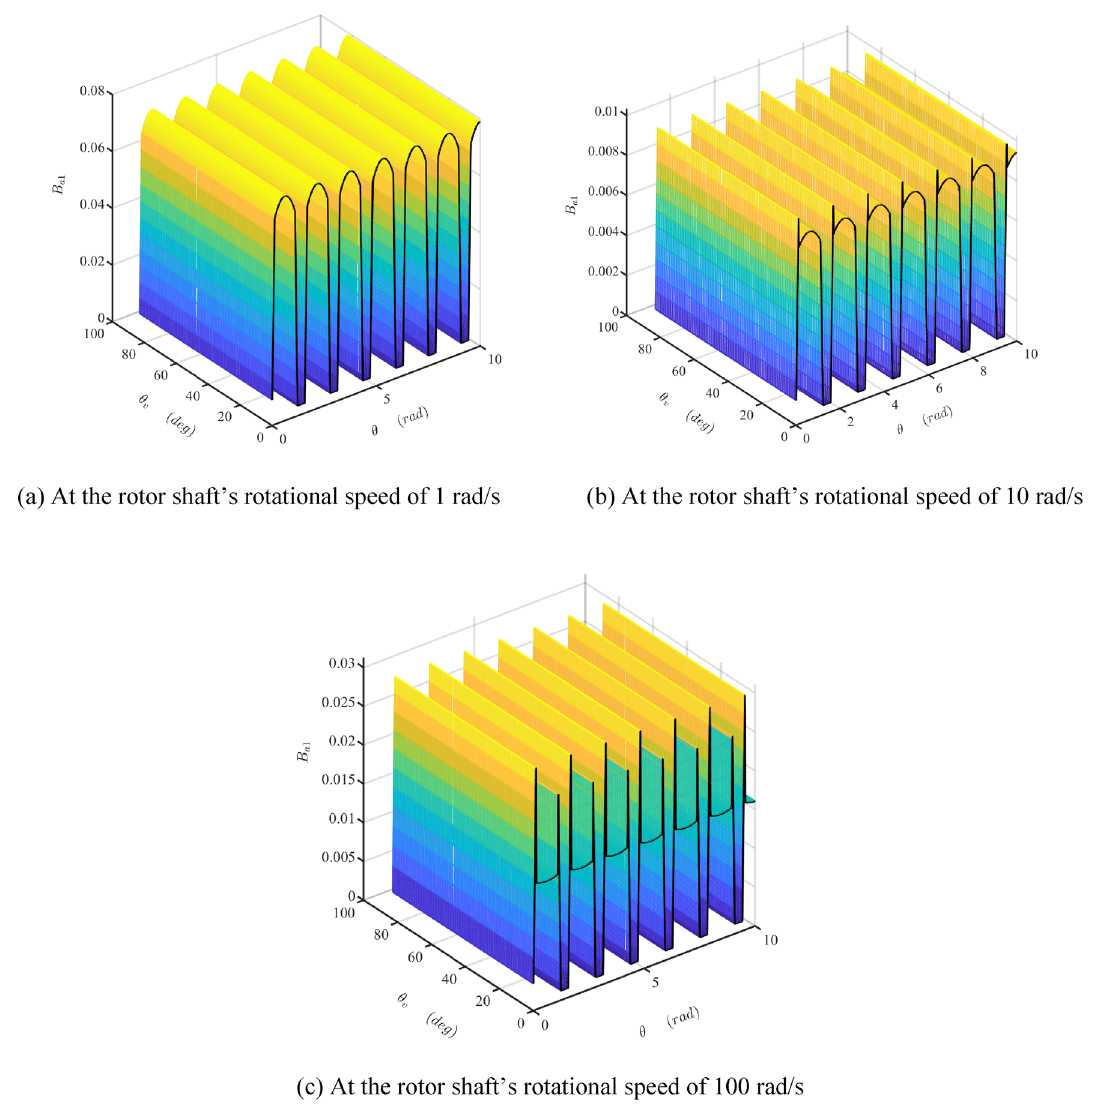
Figure 13. The map of the damper coefficient B a1 at three different the rotor shaft’s rotational speeds. (Matlab2019a. https:// ww2. mathw orks. cn/ produ cts/ get- matlab. html?s_ tid= gn_ Figure 15 indicates the maximum value of the B a2 (denoted as B a2max ) linearly increases in ̇𝜃 -axis and non- linearly increased in 𝜃 v -axis. The relative range of B a2 is about 0.42 in most areas. When both the shaft rotational velocity and the valve angle are small, the friction force acts as a dominant role, and B a2 becomes very high sharply. Figure 16 presents the map of B a3 when the rotor shaft’s rotational speed increases from 1 to 100 rad/s. Similar to the tendency of B a2max , B a3 increases linearly or nonlinearly with the increase of the shaft’s rotational velocity or the valve angle, respectively. But it does not vary with the rotation angle of the shaft. Comparing Figs. 14a, 15a, and 16, it is clear that B a3 is a dominant component in the total damping coefficient when the rotational velocity of the shaft and the angle of the valve are big. Therefore, the maximum value of the damper coefficient, B max , is close to the B a3 , as shown in Fig. 17a. Consequently, the fluctuation of the total damping coefficient is smaller at the bigger value of the high rotational velocity of the shaft and the angle of the valve, as shown in Fig. 17b. To analysis the influences of the components’ fluctuation on that of the total damping coefficient, a new index is adopted, which is the quotient of the maximum value of the component and that of the total damping coefficient. Figure 18a,b are the mesh surfaces of the indexes, i.e., B a 1max ∕ B max and B a 2max ∕ B max , respectively. Figure 18a indicates that the fluctuation of B a 1 influences the damper coefficient B greatly in regions of the low rotational velocity of the shaft and small angle of the valve. However, this influence could be ignored due to the small value of the damper coefficient component B a 1 . Figure 18b suggests the maximum value of B a 2max ∕ B max is less than 0.01 m. The fluctuation of B a 2 has little influence on the damper coefficient B . Therefore, the fluctuation of the total damping coefficient decreases along with the increase of itself.